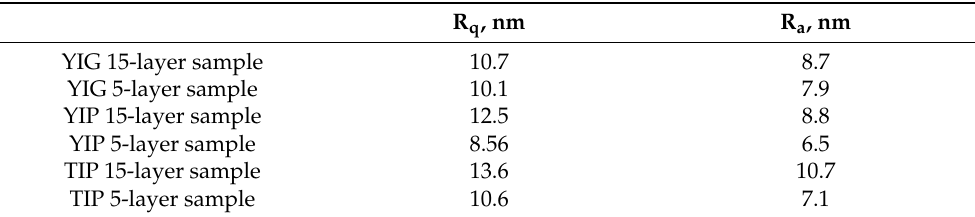
Figure 6. Atomic force microscopy results for indicated coatings. Table 2. Average (R a ) and root mean square (R q ) roughness of indicated dip-coating samples as measured by AFM.